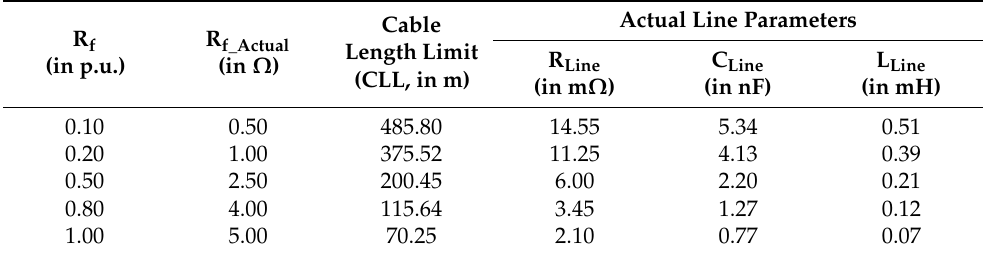
Table 3. Summary of identified Cable Length Limits (CLLs) versus fault levels. R f (in p.u.)